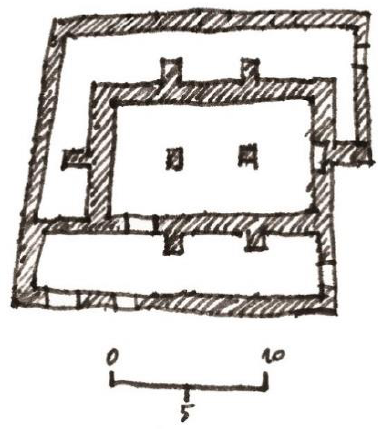
Figure 20. Prague, Old New Synagogue, last quarter of the 13th century. Sketch: Anja Premk.